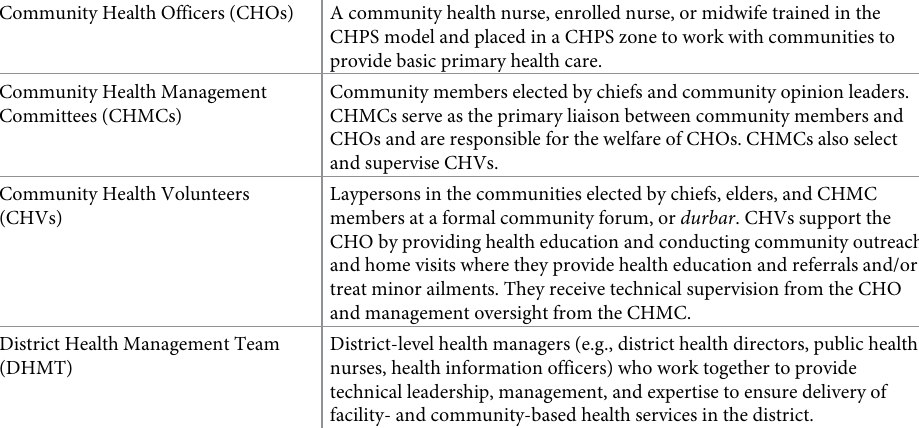
Table 1. Members of the CHPS